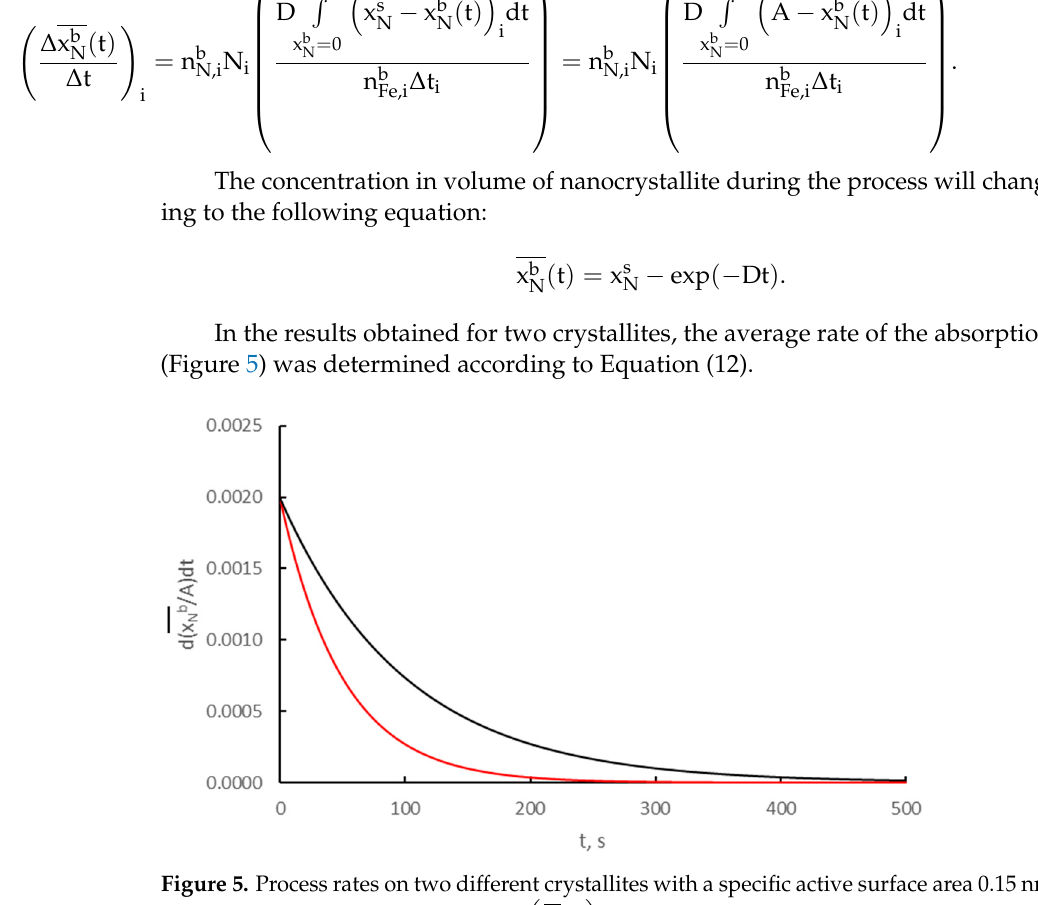
(cid:18) (cid:19) ( ) x b ( t ) b   Atx /dt = f(t) with a diffusion coefficient D = 0.1 nm 2   A /dt d = f(t) with a diffusion coefficient D = 0.1 nm 2 /s.